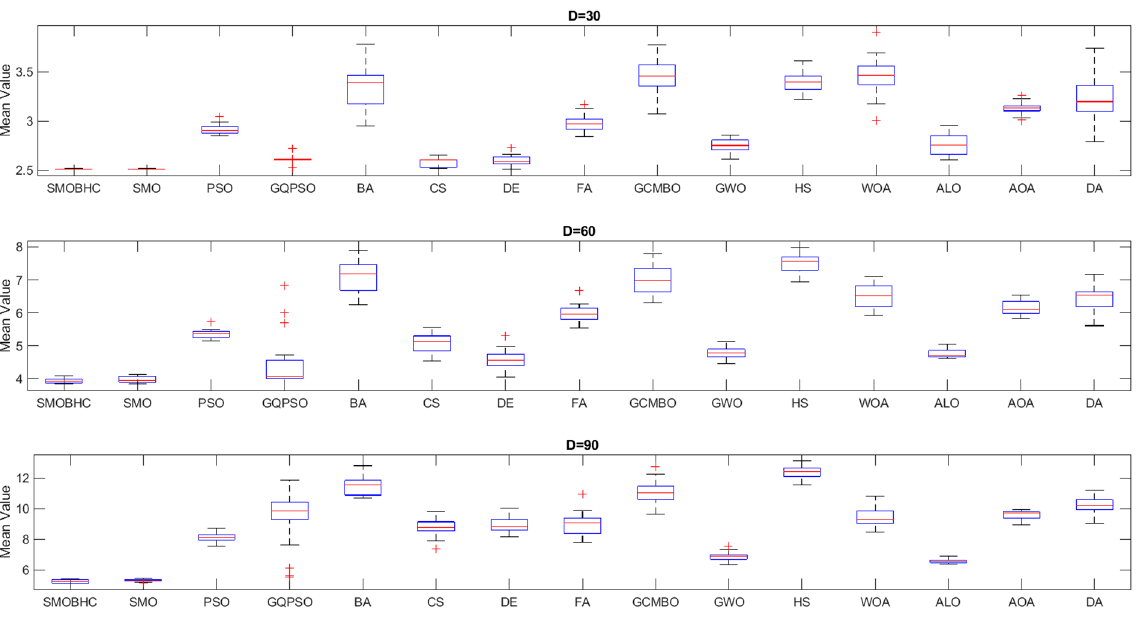
Figure 16. Boxplot graphs of mean values relative to all algorithms for battlefield 2 with 𝐷 = 30 , 60, and 90.